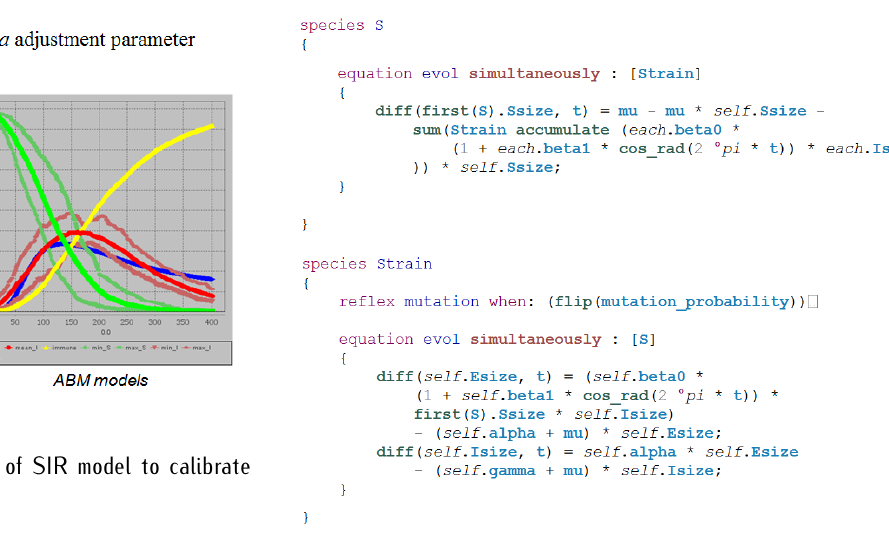
Figure 8. Multi-strain SIR model declared in Gama platform